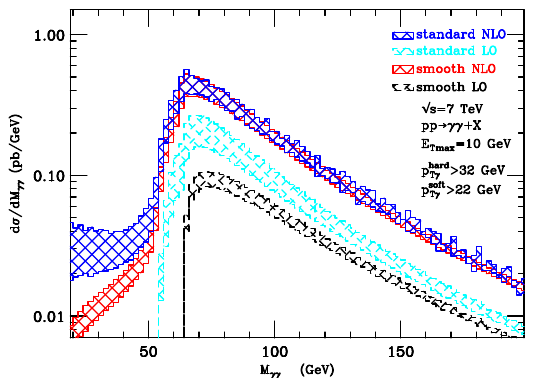
Figure 6 . The M γγ differential cross section for E T max = 10 GeV with the same photon kinemat- ical cuts as in figure 3-right and an increased cut on the minimum value of p hard The scale variation bands of the LO and NLO results for smooth and standard isolation are as fol- lows: LO smooth isolation (black dashed), LO standard isolation (light-blue dashed), NLO smooth isolation (red solid) and NLO standard isolation (blue